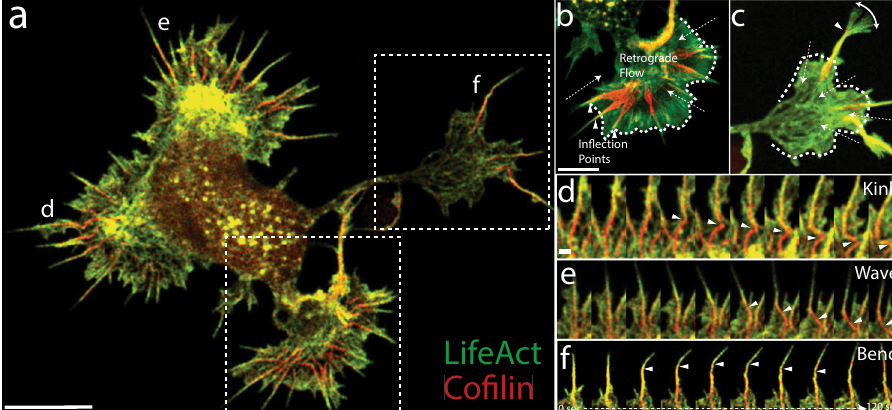
Fig. 6 Co fi lactin bundles facilitate bending and breaking of fi lopodial protrusions. a Single image of a whole-cell expressing tdTomato-Lifeact (pseudocolored green) and EGFP-co fi lin (pseudocolored red). b , c Maximum intensity projections (MIP) of lower and upper boxed regions in a , respectively. MIPs include 40 images at 3 s intervals for 2 min total. Filopodia in b are examples of “ resting ” fi lopodia and ( c ) shows a “ searching ” fi lopodium. Dashed arrows indicate the direction of actin retrograde fl ow, and arrowheads indicate in fl ection points seen along the fl exing fi lopodial bundles. The white dashed line marks the position of the lamellipodial veil. d – f 2-min movie montages showing behaviors exhibited by the co fi lin-rich fi lopodia designated with the corresponding label in a . Arrowheads follow either a kink/breaking point ( d ), a co fi lactin bundle “ wave ” ( e ), or an in fl ection point in a bending fi lopodium ( f ). In e , the wave is caused by the fi lopodial tip moving from left to right, which drags the attached base behind it in a fl exible, wave-like motion. The localization of EGFP-co fi lin and tdTomato-Lifeact shown in a was replicated in multiple cells from two independent experiments, and similar results were also seen using other fl uorescent protein combinations (Supplementary Fig. 5). Scale bars: ( a , b ) 5 µ m (scale bar in b also corresponds to image in c ), ( d ) 500 nm (also corresponds to ( e ) and ( f